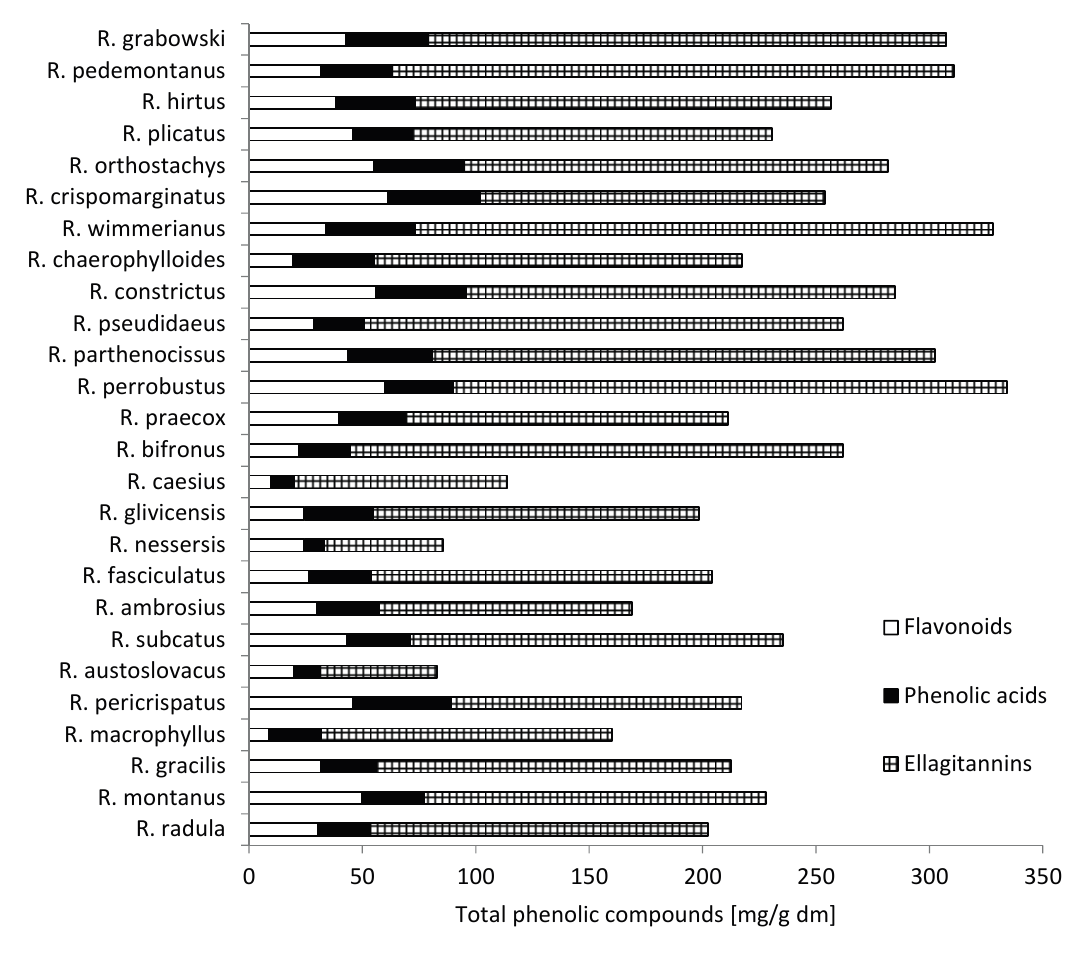
Figure 1. Content of total phenolic compounds in leaves [mg/g dm] from wild Rubus L.